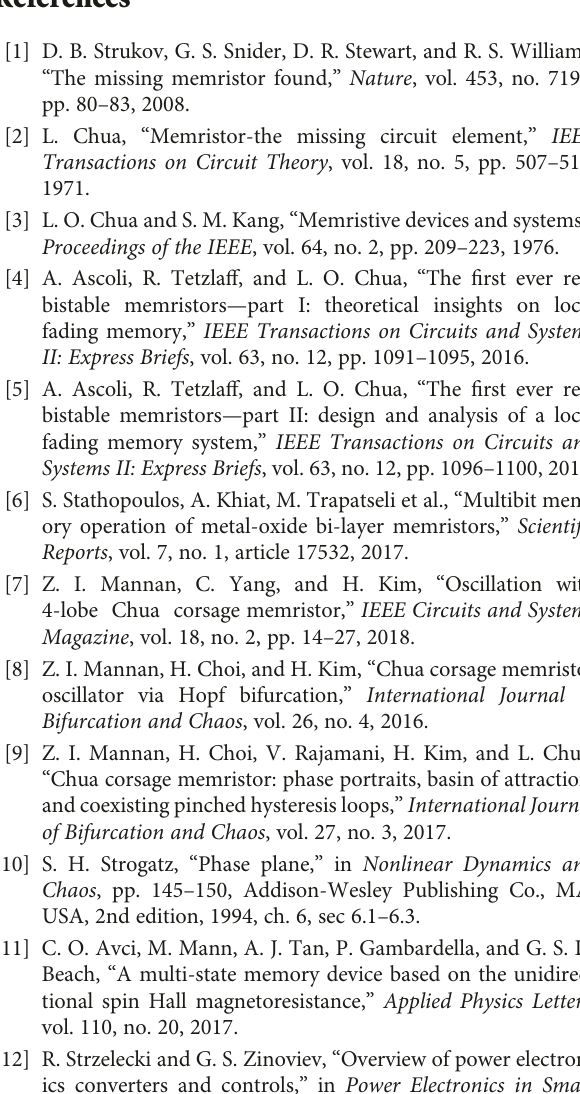
versus pulse width Δ w of the real 6-lobe Chua corsage memristor A